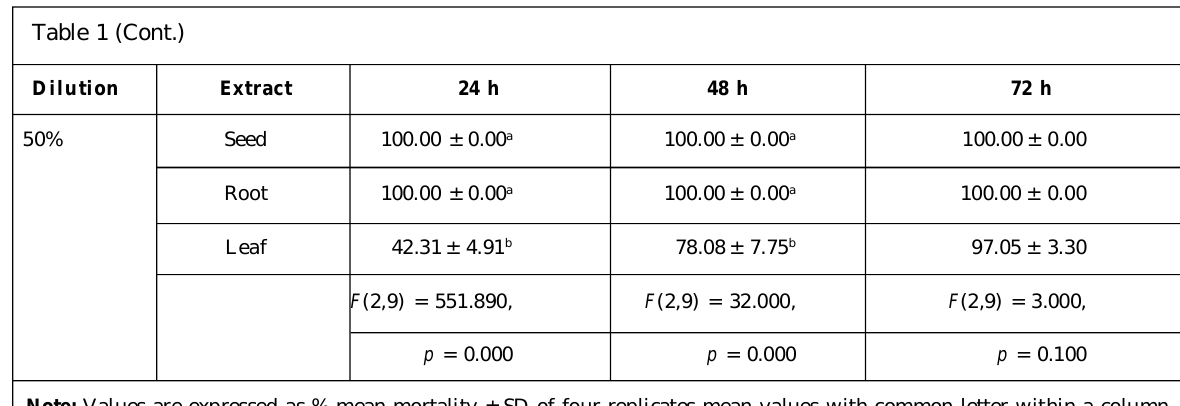
Note: Values are expressed as % mean mortality ± SD of four replicates mean values with common letter within a column are not significantly different ( p = 0.05) according to LSD